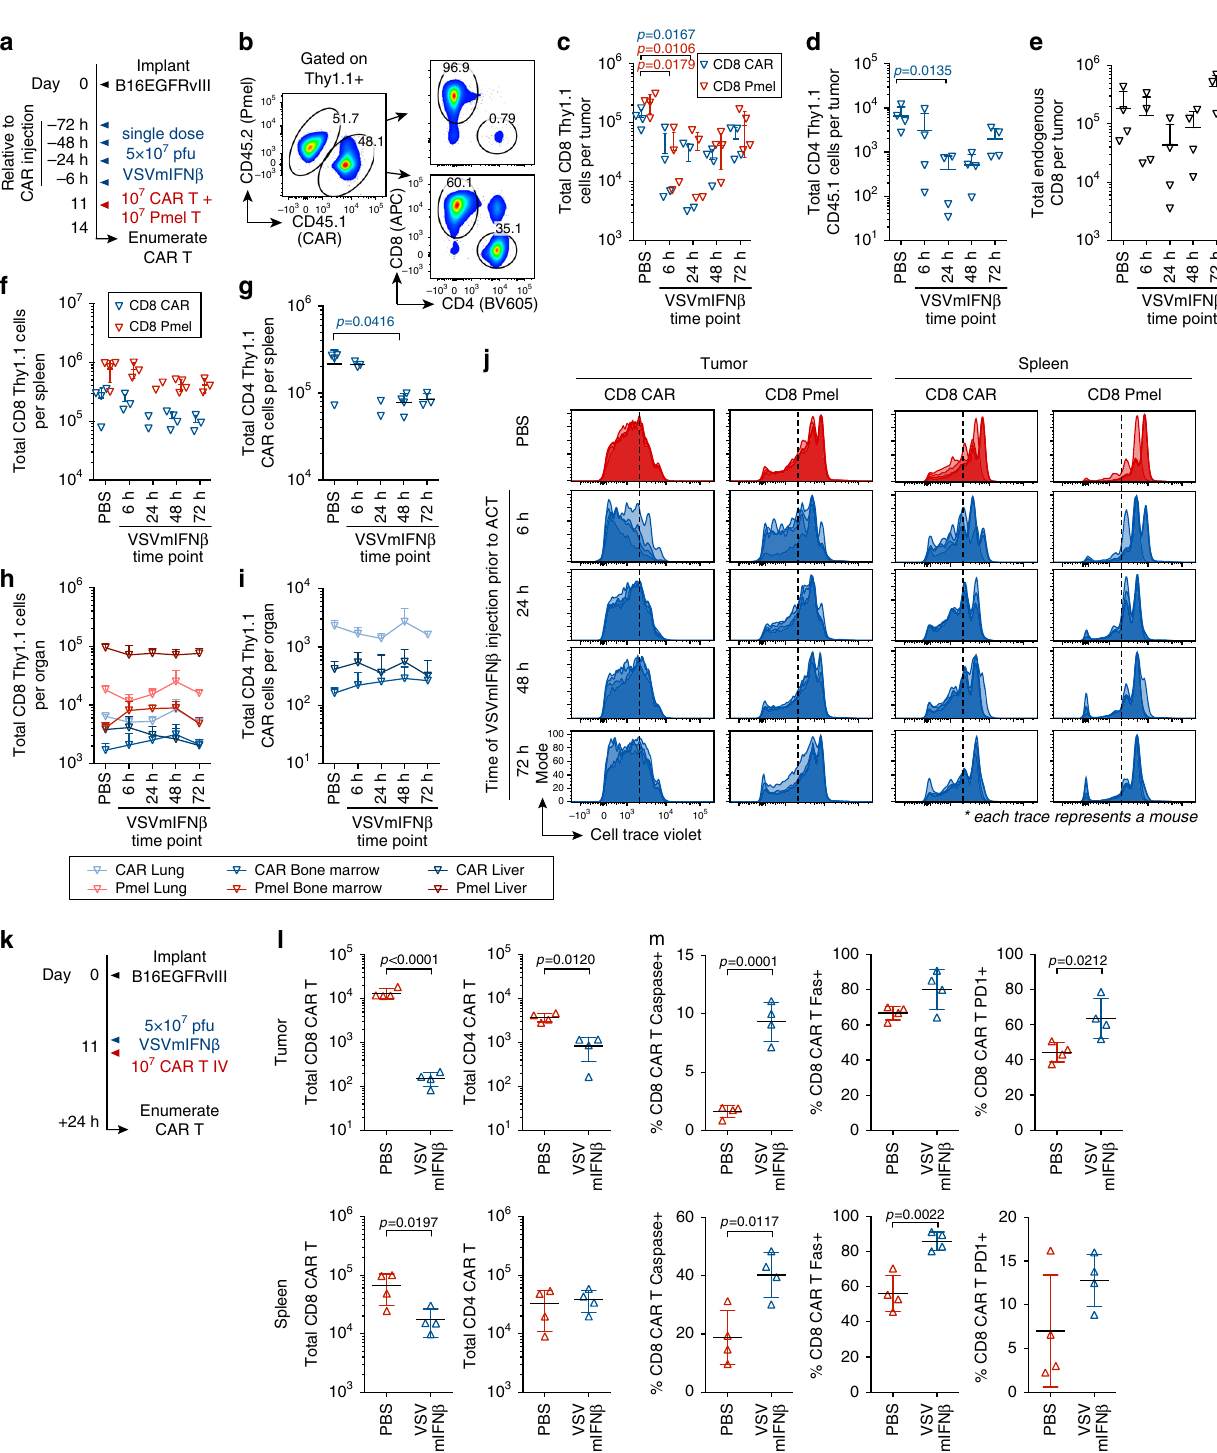
VSVmIFN β -associated attrition was also evaluated in a subcutaneous CT2AEGFRvIII tumor model which supports VSV